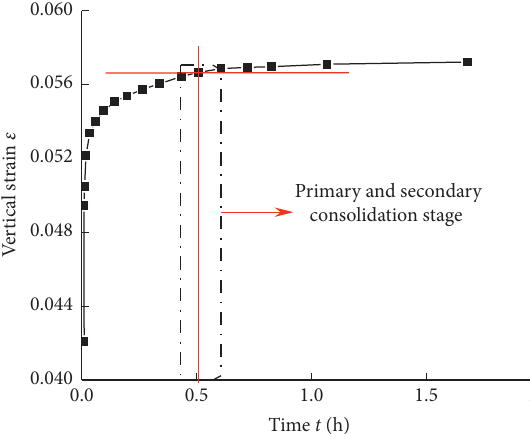
Figure 6: Strain-time curve at E